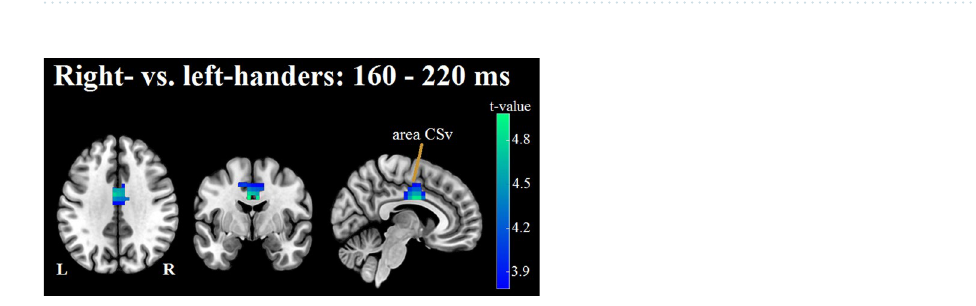
Figure 5. Condition difference (i.e. coherent mean amplitude minus incoherent mean amplitude) in right- versus left-handers. Cluster-based permutation tests were conducted to identify clusters of electrodes showing a significant condition difference between left- and right-handers in the early (160–220 ms) and late (260–300 ms) windows. For illustration purposes, condition differences between the two groups are plotted as right-hander condition difference minus left-hander condition difference. In the early window, a central cluster of electrodes (indicated by large black dots over respective electrode positions) exhibited a significant condition difference between the two groups, reflecting a larger mean amplitude difference in left- versus right-handers. That is, although both groups exhibited smaller mean amplitudes in the coherent relative to the incoherent condition, the difference between conditions was larger for left-handers. No significant differences were observed in the late window.